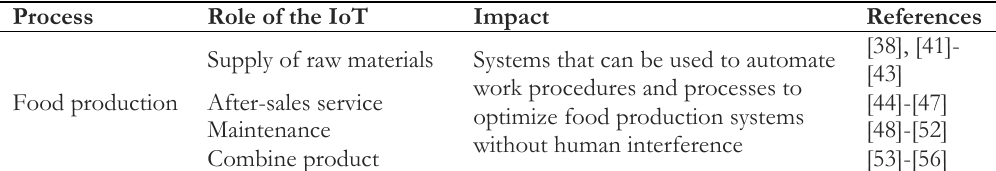
Table 5. Applications of the IoT in food production in the food supply